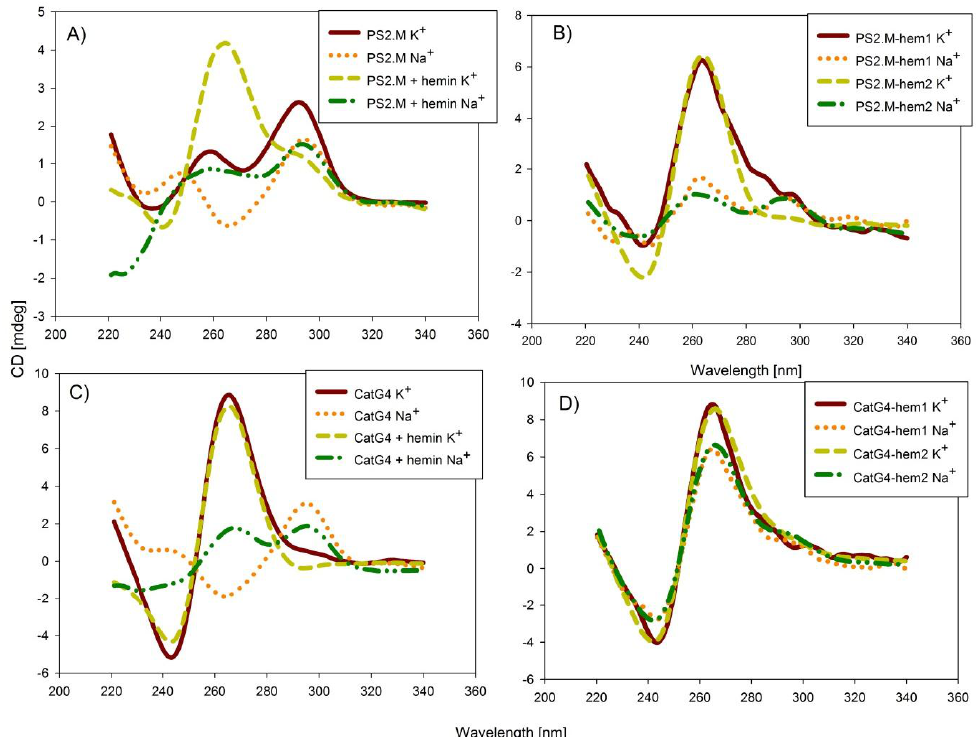
Figure 1. Circular dichroism (CD) spectra of the studied systems in the presence of either potassium or sodium cations: ( A ) PS2.M and PS2.M/hemin complexes, ( B ) PS2.M–hemin conjugates, ( C ) CatG4 and CatG4/hemin complexes, and ( D ) CatG4–hemin conjugates. Conditions: 2 µM DNA, 2 µM hemin (if present), 100 mM KCl or NaCl, and 10 mM Tris-HCl (pH 8.0). Experiments were performed in triplicate.